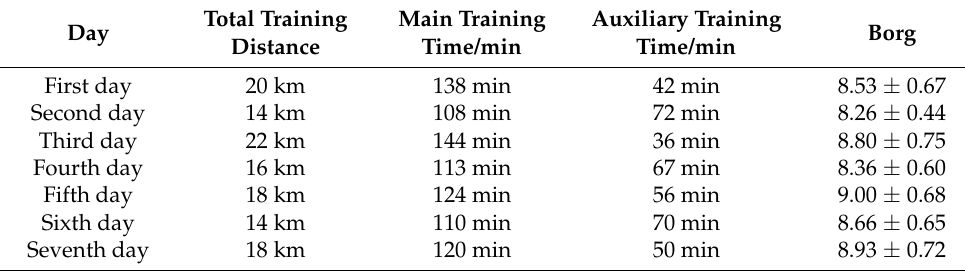
Table 2. Training volume and training